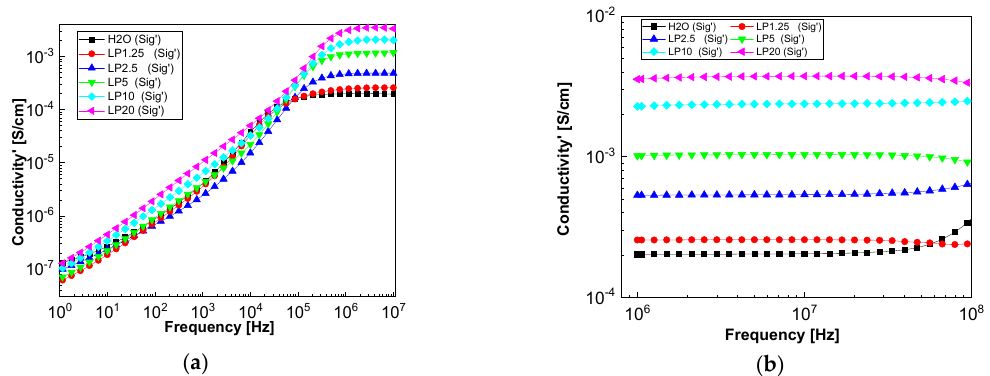
Figure 12. The dependence of real part of conductivity with frequency, in the range of low ( a ) and high ( b ) frequencies, when the concentration of the LP( 1 ) solution varies from 0 (black curve) to 0.125 mg/mL (red curve), 0.25 mg/mL (blue curve), 0.5 mg/mL (green curve), 1 mg/mL (cyan curve) and 2 mg/mL (magenta curve).